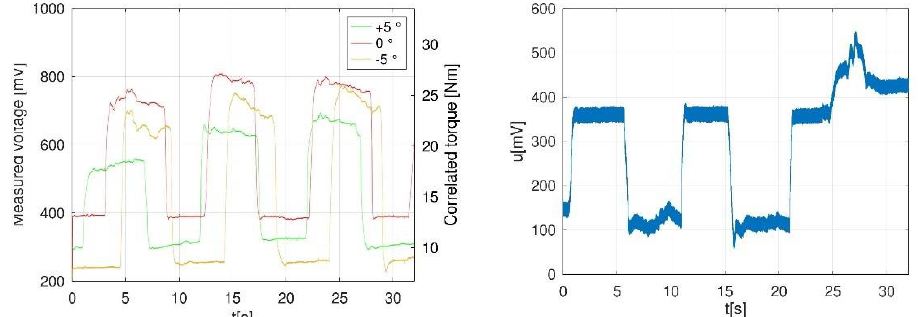
Figure 7. Three captured time series (5 s of contraction and 5 s of relaxation between contractions) for the same participant, right foot, with various initial pedal inclination (+5°, 0°, −5°) during plantar flexion, and resulted voltage in mV and correlated torque in Nm ( left ); example of error of meas-